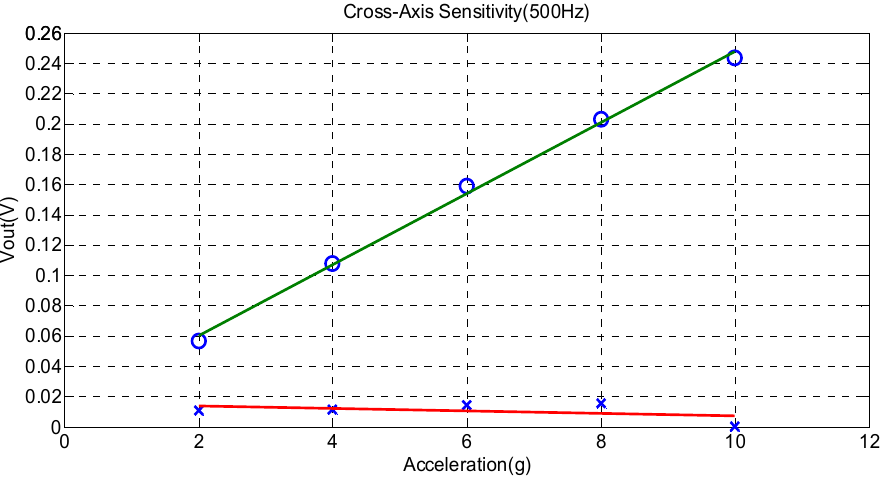
Figure 6. The linearity character and cross ‐ axis sensitivity of MEMS accelerometers at 500 Hz.